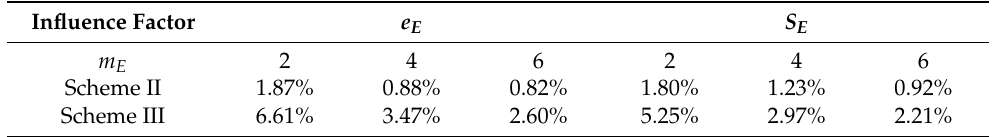
Table 2. Inversion error of Young’s modulus field of schemes II and III.